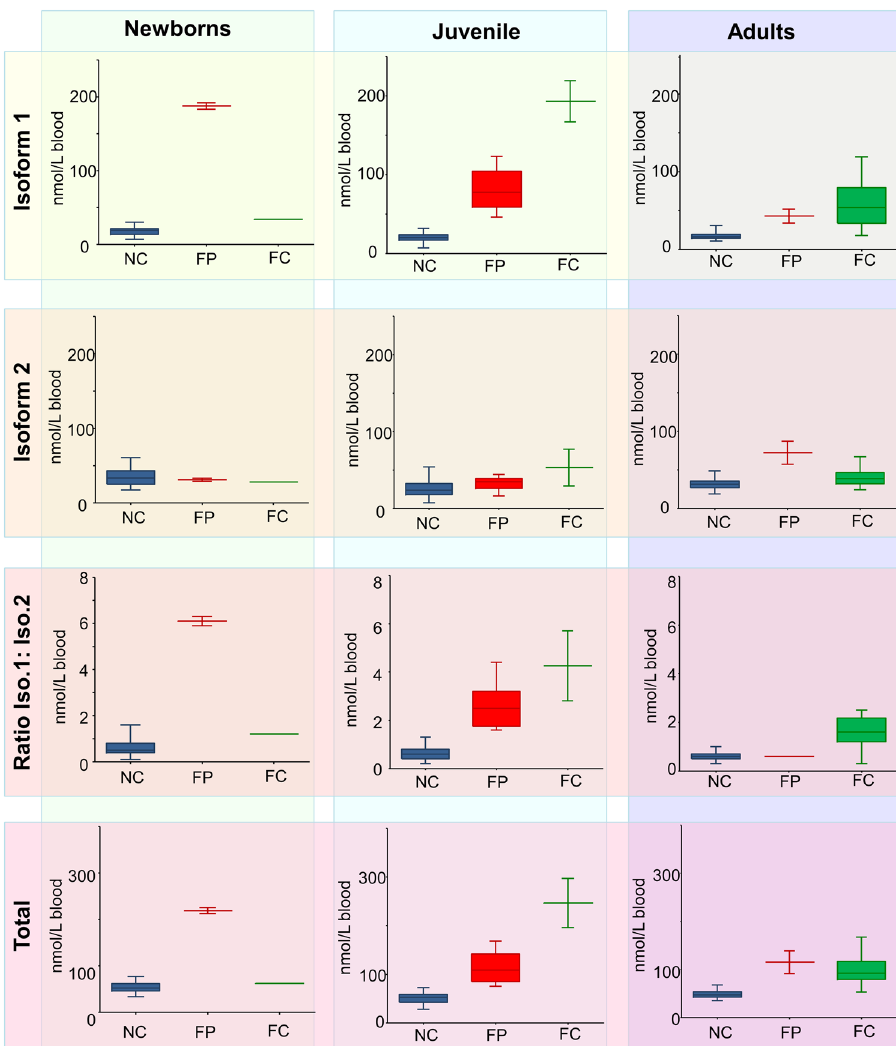
Figure 3. Box plots demonstrating C26:0 ceramide levels in the blood of NC, FP and FC, grouped according to the donors’ ages in newborns (up to 6 months), juveniles (6 months to 17 years) and adults ( > 17 years). NC = healthy controls, FP = Farber patients, FC = Farber